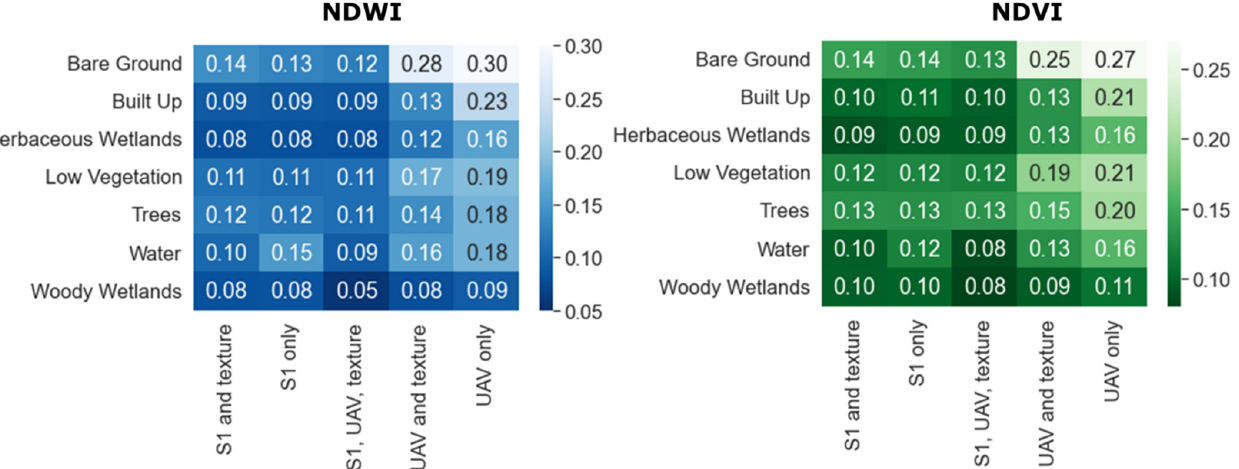
Figure 6. The breakdown of Mean Absolute Error (MAE) across the different land cover types for each of the dataset combinations applied to the random forest model.